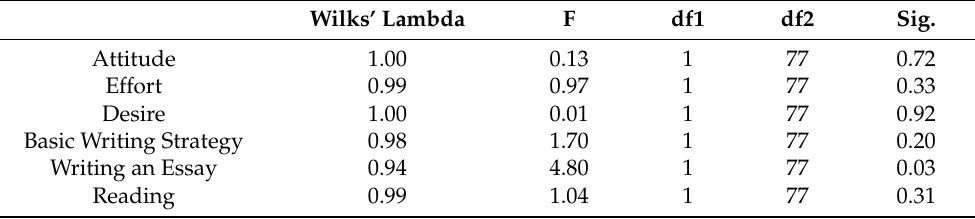
Table 2. Tests of Equality of Group